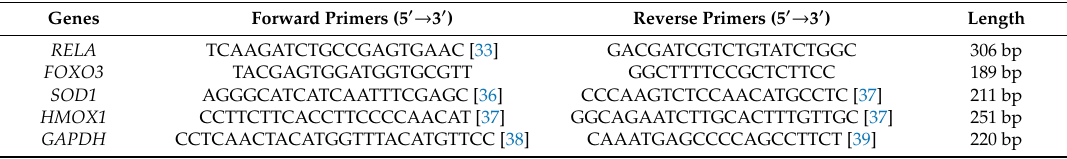
Table 1. Primer information for antioxidant-associated genes *.